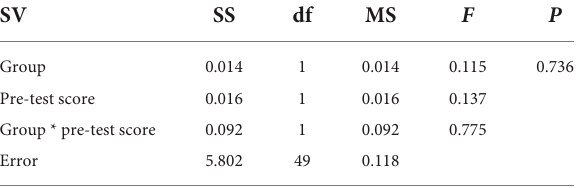
TABLE 6 The statistical analysis of pre-test results of learning attitude. TABLE 8 The significant results of ANCOVA analysis of pre-test and post-test results of learning attitude.